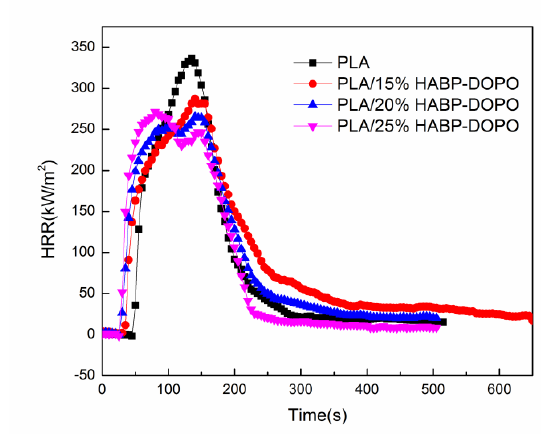
Table 4. Cone calorimetric test data for PLA/HABP-DOPO blends.